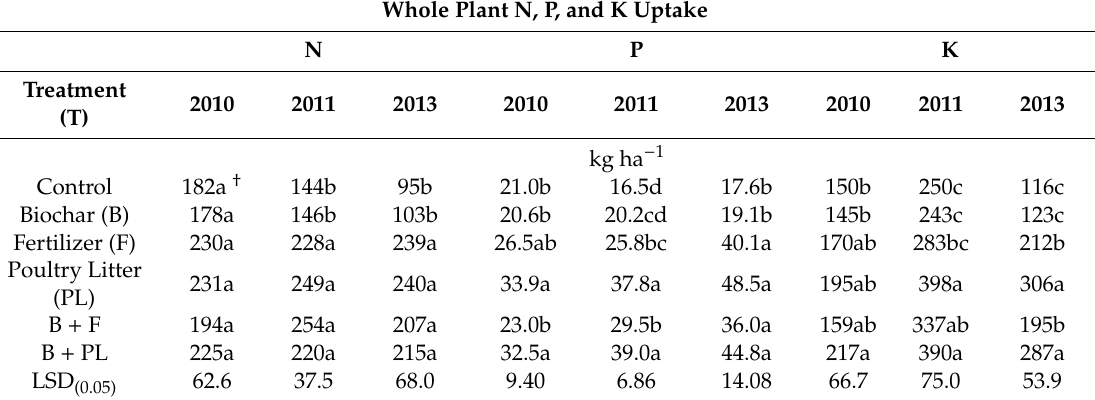
Table 4. Whole plants nutrients (N, P, and K) uptake influenced by di ff erent treatment and growing season